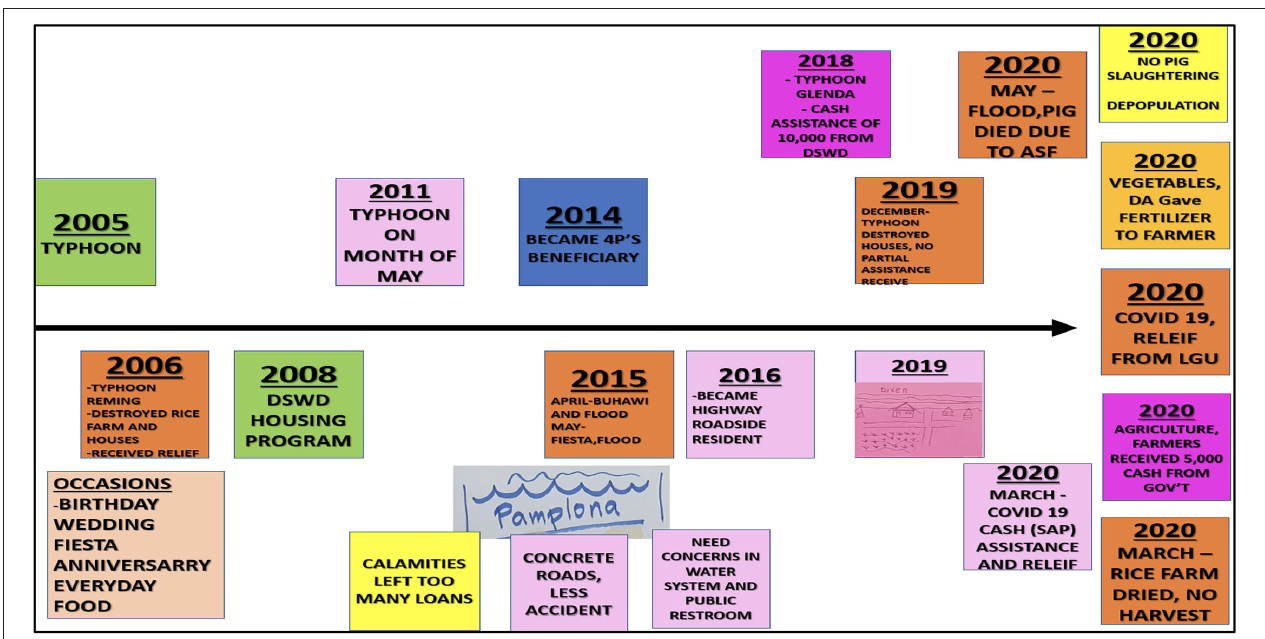
FIGURE 4 | Community timeline developed by women farmers during focus group